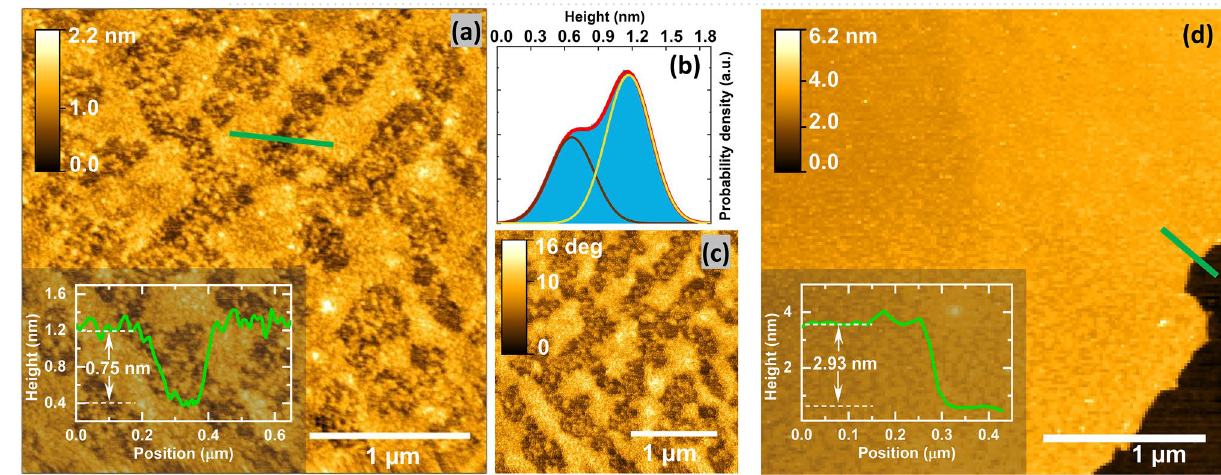
Figure 2. Spectroscopic MoS 2 characterization and mechanism of spatially varying MoS 2 deposition. ( a ) Raman and PL spectra mapped along a 300-µm line within the MoS 2 ripple pattern (step size: 2 µm; microscopy image of the sample area shown in the inset; sample preparation parameters: droplet-dragging speed of 67 µm/s, halts every 200 µm). For each measurement position, the combined intensity of both Raman lines (blue curve) and the PL intensity (dashed, orange curve) are analysed. The extracted Raman peak-to-peak values δ are printed as a color coded band (top). All signals are obtained by averaging over spectra from three adjacent probing positions. ( b – d ) Raman and PL mapping of a 300 µm × 80 µm area (sample preparation parameters: droplet-dragging speed of 80 µm/s, halts every 200 µm). The darker regions in panel ( b ) and ( c ) indicate areas with monolayer domains with low coverage (small Raman intensity and low δ value). In panel ( d ), the highly luminescent domains related to monolayer-MoS 2 are visible on the border regions. ( e ) Schematic representation of the shape of the dragged droplet and its change when halting the relative movement of the needle. The dynamics of the receding part of the trailing droplet results in a spatial modulation of the local precursor deposition.